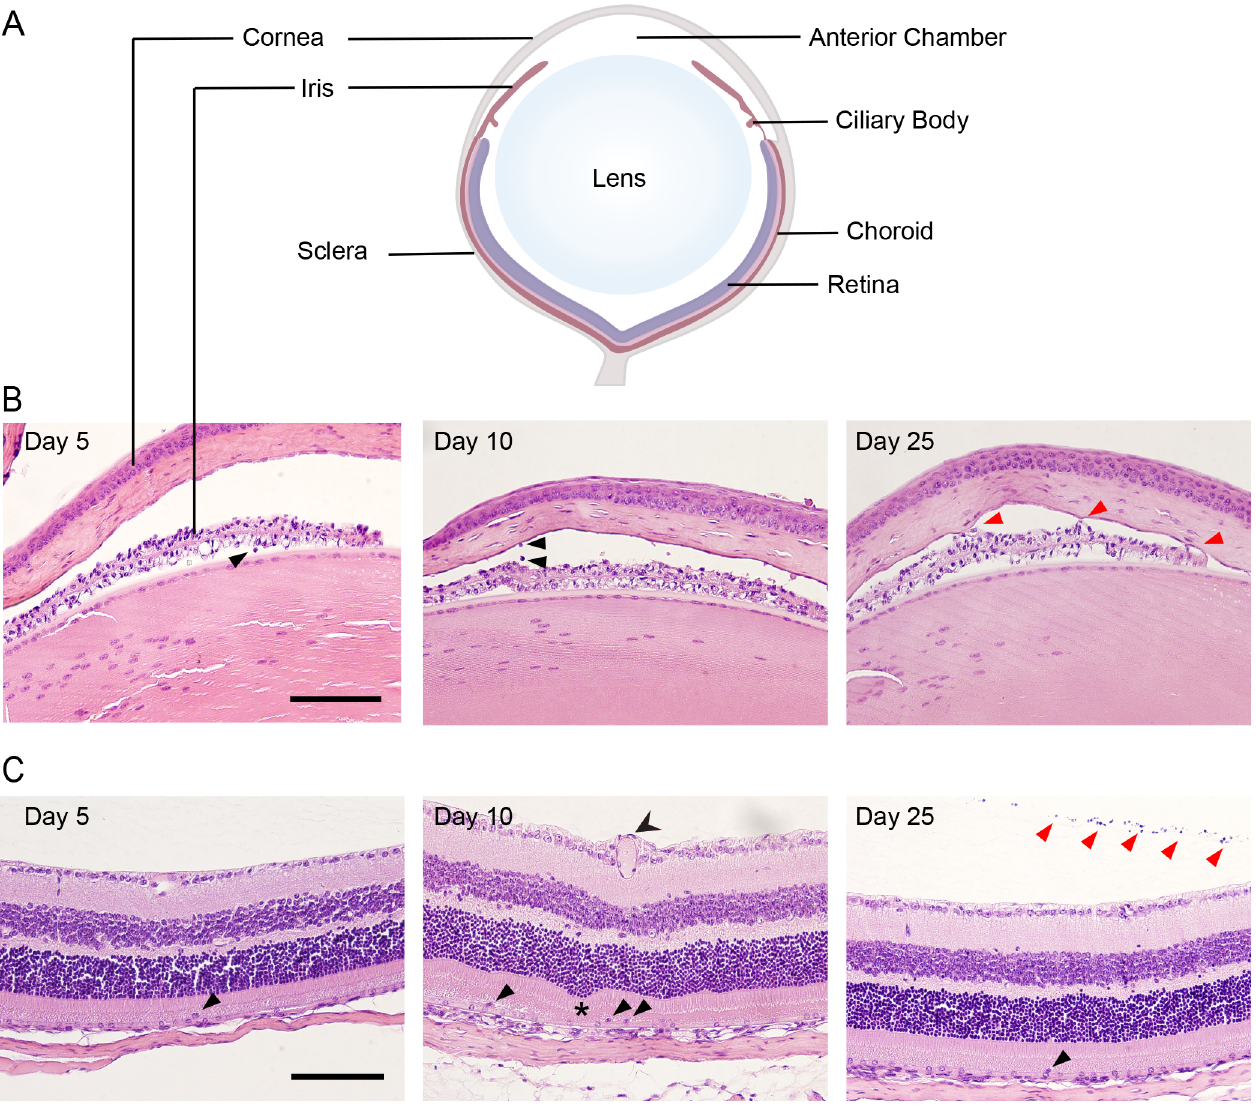
Fig 2. MCMV infection causes inflammation in the iris and retina. (A) Schematic diagram with the major compartments of the eye labelled. (B) Sections of the anterior chamber at the indicated times pi were stained with haematoxylin and eosin. Thickening of the iris was evident at day 5. Cellular infiltrates and keratic precipitates were present after infection (black arrows). Synechia (adherence of the iris to the cornea) was frequently observed (red arrows). (C) Haematoxylin and eosin stained sections of the retina show normal structure at day 5 pi. Enlarged vessels (two tailed arrow head), folds in the retina (asterisk) and infiltrating cells were present (black arrows) at day 10pi. At day 25 pi infiltrating cells within the retina (black arrow heads) and the vitreous (red arrow heads) were evident. Scale bar: 100 μm. Results are representative of those from 5 mice per time-point. day 25 pi, including cell infiltration ( Fig 2B, black arrows ) and synechiae (Fig 2B, red arrows ). The retinal structure was also affected following infection; at day 10 pi retinal vessel enlargement ( Fig 2C, double tailed arrow ) and occasional retinal folding ( Fig 2C, asterisk ) were observed, together with inflammatory cells in the subretinal space ( Fig 2C, black arrows ). Mild vitritis ( Fig 2C, red arrows ) and rare inflammatory cells in the subretinal space were present at day 25 pi ( Fig 2, black arrow ).